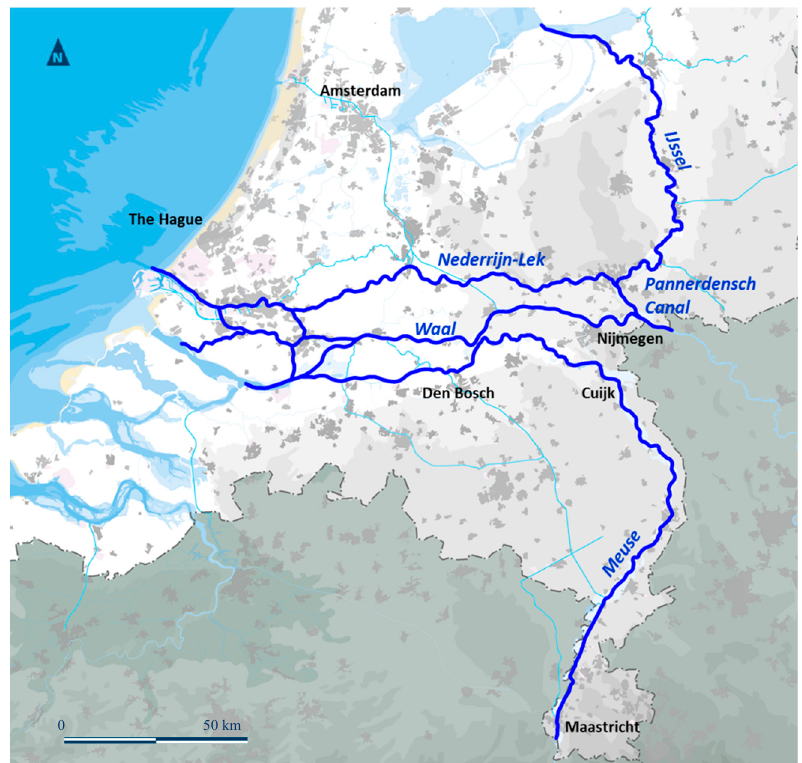
Figure 1. The Meuse river enters the Netherlands from Belgium in the south and the Rhine River enters from Germany at the eastern border and then branches into Waal, Nederrijn-Lek and IJssel in a proportion of 6:2:1 during flood discharge.